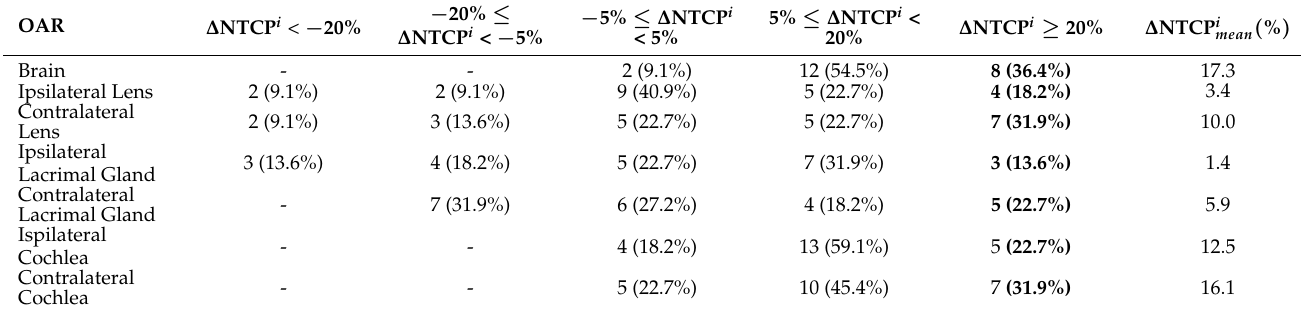
Table 6. Results for intermediate toxicities investigation. The number of patient cases with ∆ NTCP i values in the selected intervals is reported. Percentage values over the entire patient cohort is showed in brackets. Values in bold character fulfill the condition 1a.